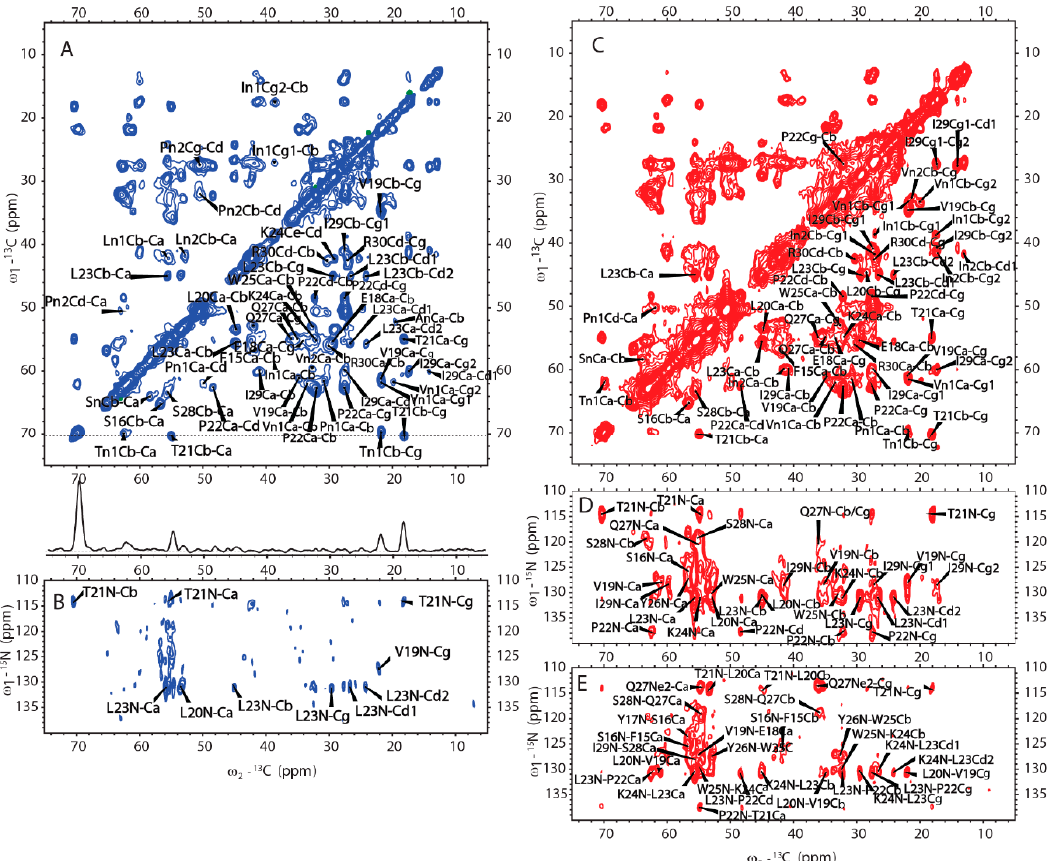
Figure 6. The MAS SSNMR spectra acquired from the samples prepared at pH 6.0 (left) and at pH 4.5 (right) using uniformly [ 13 C, 15 N]-labeled H175. ( A ) 2D 13 C- 13 C DARR correlation spectrum with a DARR mixing time of 50 ms and ( B ) 2D 13 C- 15 N NCaCx spectrum for the sample prepared at pH 6.0. ( C ) 2D 13 C- 13 C DARR correlation spectrum with a DARR mixing time of 25 ms. ( D ) 2D 13 C- 15 N NCaCx spectrum. ( E ) 2D 13 C- 15 N NCoCx spectrum for the sample prepared at pH 4.5.